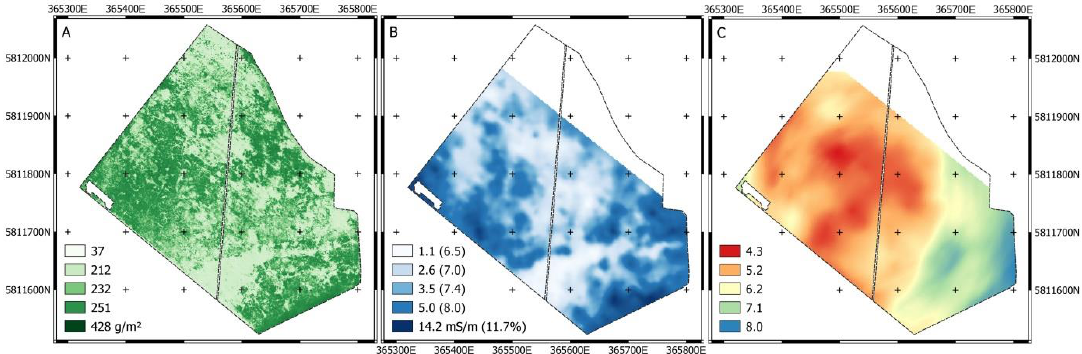
Figure 8. ( A ) Sensor-based estimate of dry grassland biomass, ( B ) soil ECa deep with soil moisture in parentheses, and ( C ) pH value at Königsfeld.